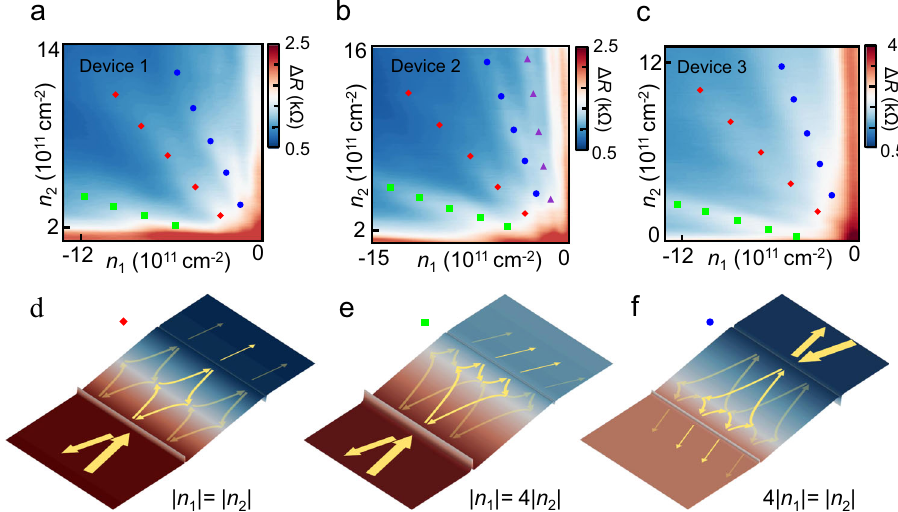
Fig. 2 | Veselago interference and localization. a – c Measured 4-probe resistance of cavity as a function of n 1 and n 2 in three devices. Resistance peaks are visible at | n 1 |=| n 2 | (red), | n 1 |=4| n 2 | (green), 4| n 1 |=| n 2 | (blue) and 9| n 1 |=| n 2 | (purple), d When | n 1 |=| n 2 |,asymmetricpn-junctionisde fi nedinthecavity.Carriersinjectedintothe cavity (with a low probability p and a small incident angle) undergo Veselago